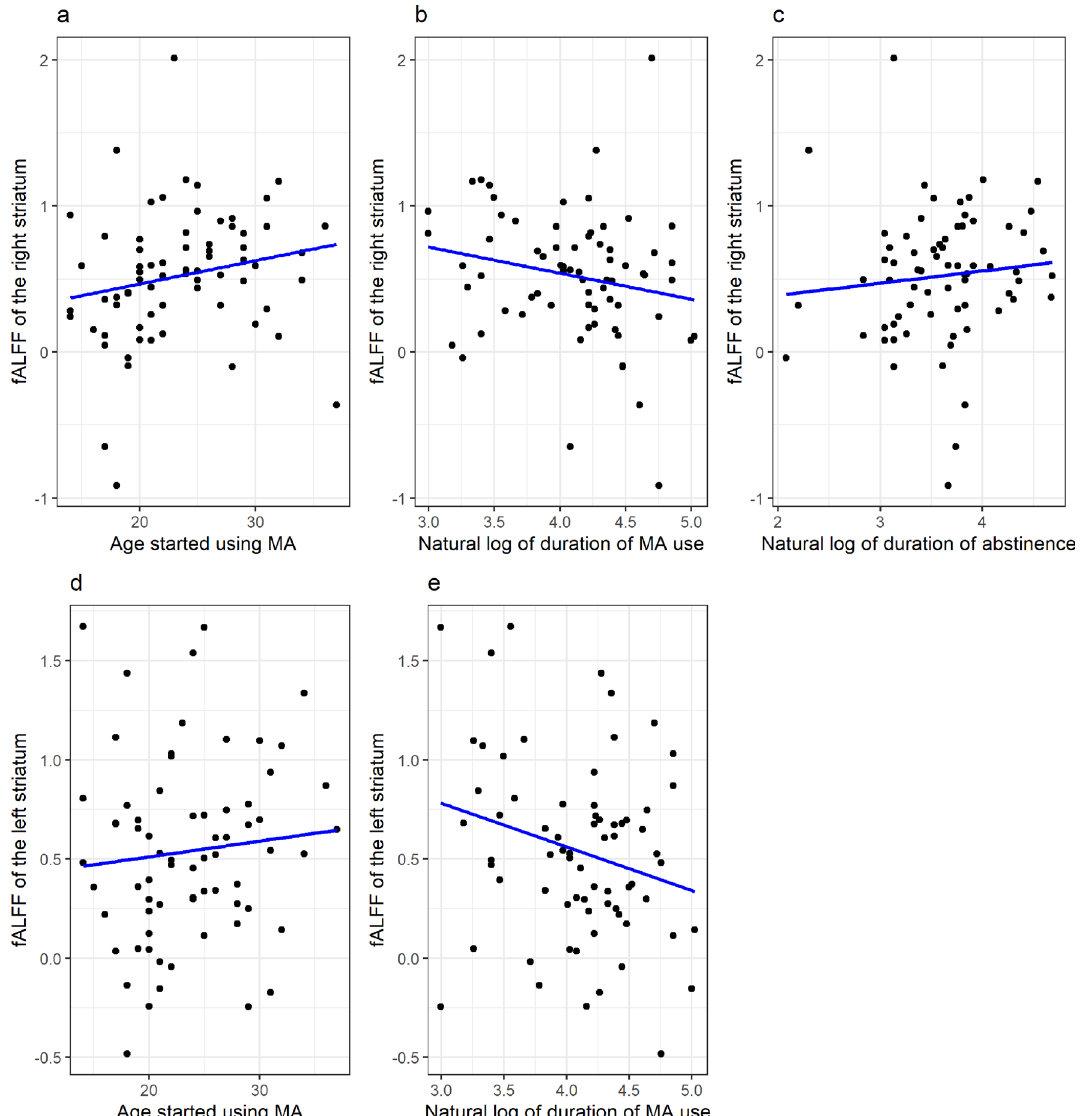
Figure 3. Correlation figures. ( a ) Relationship between the fALFF value of the right striatum and the age started using MA. ( b ) Relationship between the fALFF value of the right striatum and the natural log of duration of MA use. ( c ) Relationship between the fALFF value of the right striatum and the natural log of duration of abstinence. ( d ) Relationship between the fALFF value of the left striatum and the age started using MA. ( e ) Relationship between the fALFF value of the left striatum and the natural log of duration of MA the left caudate after CBT, along with the clinical improvement 50 . Abnormalities such as enlarged volumes 51,52 , lower metabolism 53,54 , down-regulation of levels of stored dopamine 55 , dopamine release, dopamine transporter and receptor availability in the striatum 56,57 in abstinent MADs have been reported in previous studies. These findings revealed the important roles of striatum in the pathology of MA dependence. Since these results are observed during abstinence, some of the neurotoxic effects of MA appear to be persistent, while some studies reported partial recovery in MADs with protracted abstinence 54 , some even with rapid recovery 55 . Thus, the increased fALFF and ReHo values of bilateral striatum in the present study may indicate partial recovery of striatum function in abstinent MADs. Importantly, we found that the fALFF value of the right striatum was positively correlated with duration of abstinence, which may suggest that long-term abstinence is beneficial for the recovery of striatum function, such as self-control. MADs living in an environment where there is no access to MA do not have to make as many effort as those who have access to MA, thus more resources retained for better self-control 19 , which may be related to the increased fALFF value of the striatum. Moreover, the fALFF values of bilateral striatum were negatively correlated with the duration of MA use, which may further suggest that the increased fALFF values of bilateral striatum, especially the right striatum, are associated with abstinence, or even early recovery, rather than only MA impairments. Within this context, the present findings suggest that the fALFF and ReHo values of